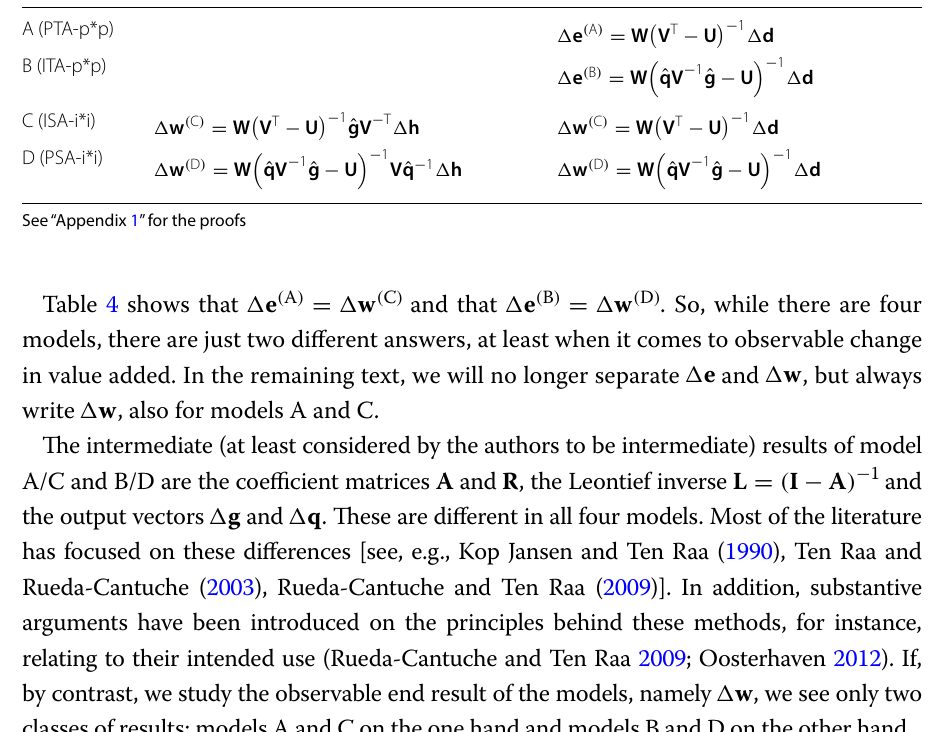
Table 4 Expressions for the satellite multiplier for models A–D Model Formula for impact analysis in terms of (cid:31) h Formula for impact analysis in terms of (cid:31)